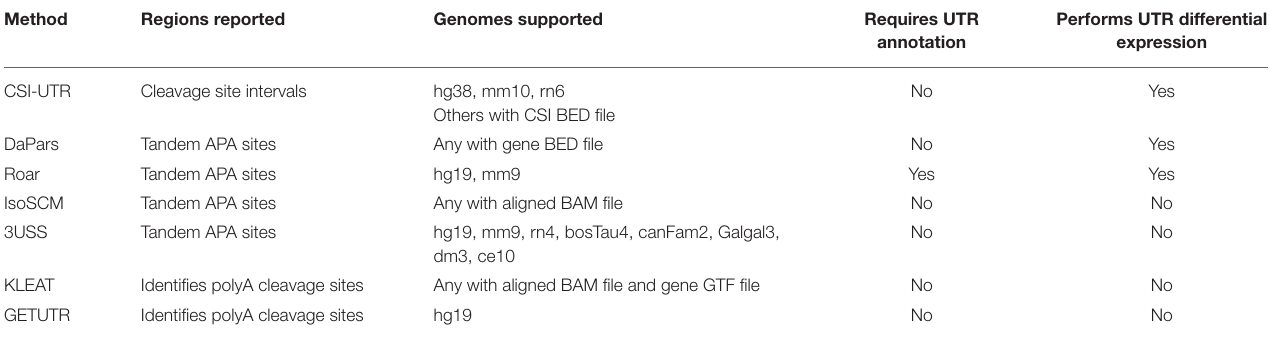
TABLE 7 | Comparison of alternative polyadenylation approaches.